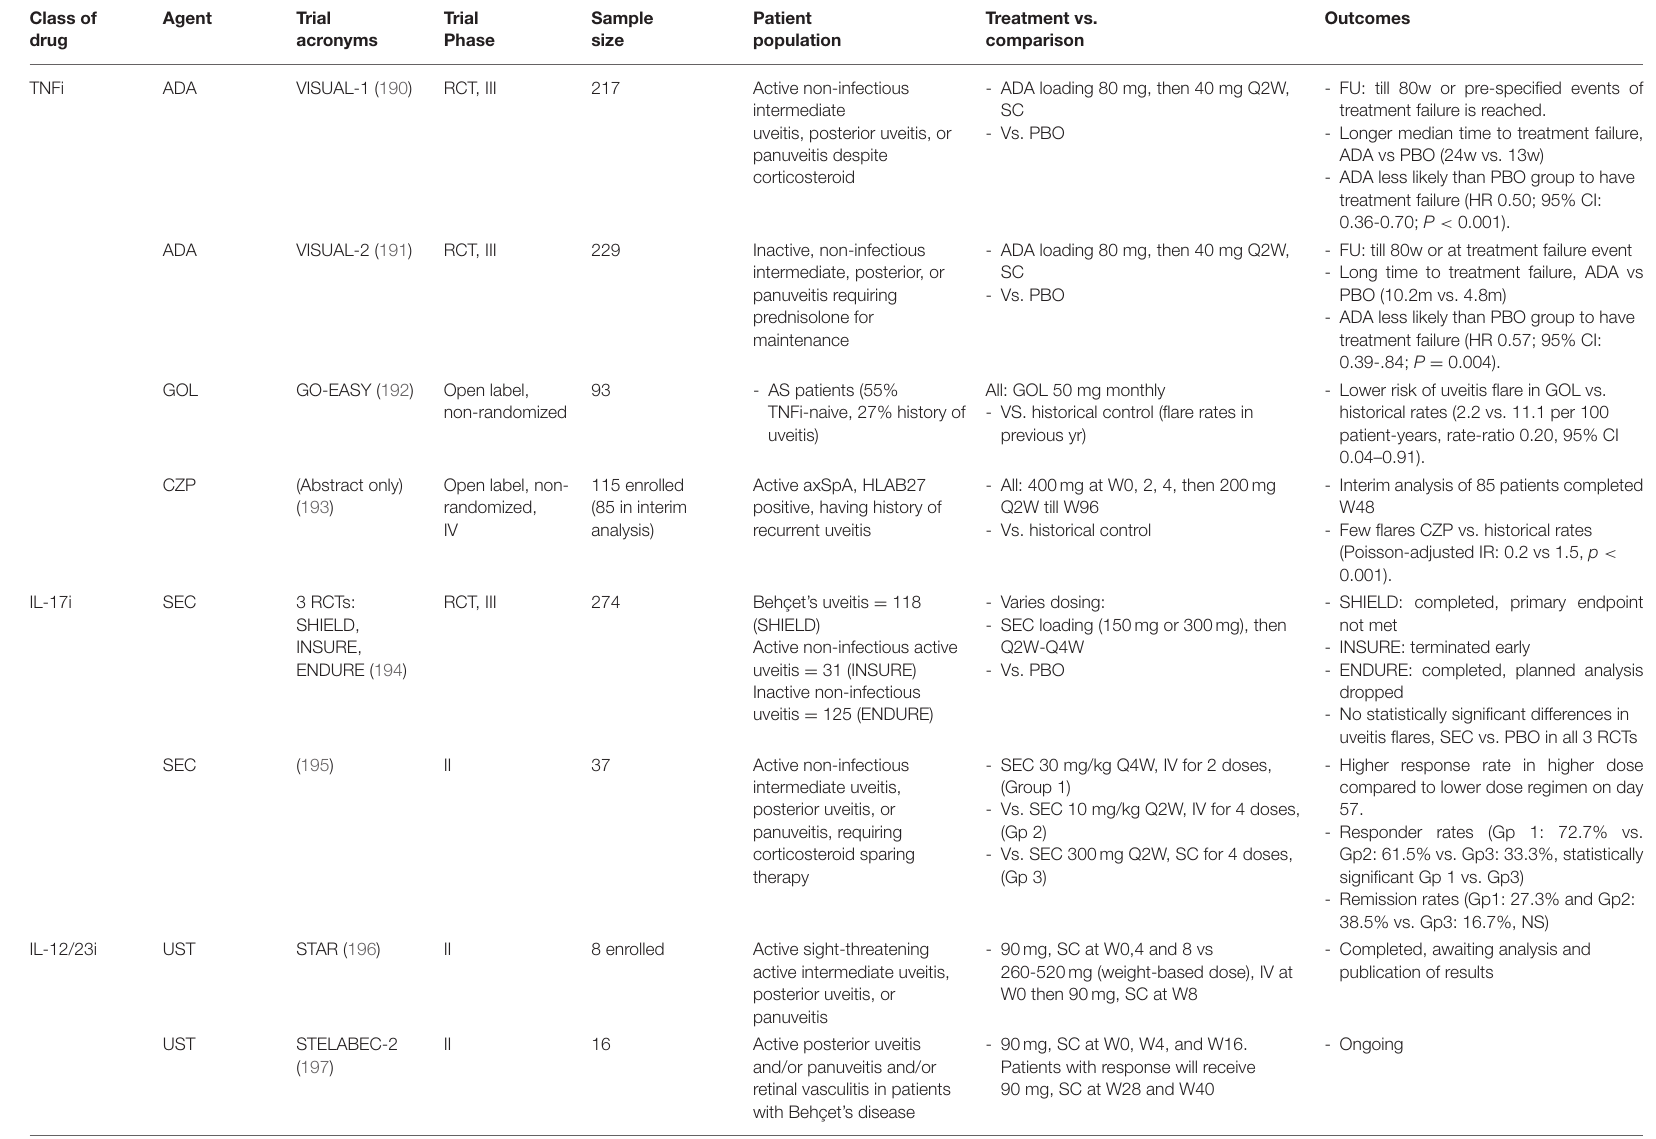
TABLE 4 | Evidence from clinical trials for class of therapeutic options for uveitis. Class of